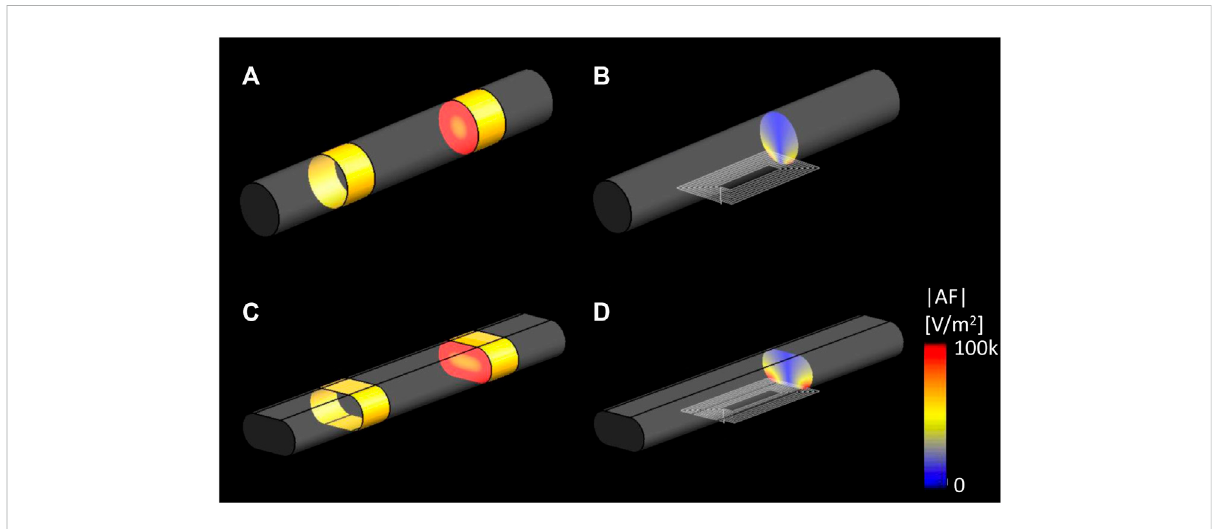
FIGURE 7 EMsimulationresultsof|E|RMS onthecylindrical andellipticalnerve.Cross-sectionedviewofthe|AF|, (A) eVNSonthecylindricalnerveand (C) fl attened nerve; (B) µM-VNS on the cylindrical nerve and (D) fl attened nerve.